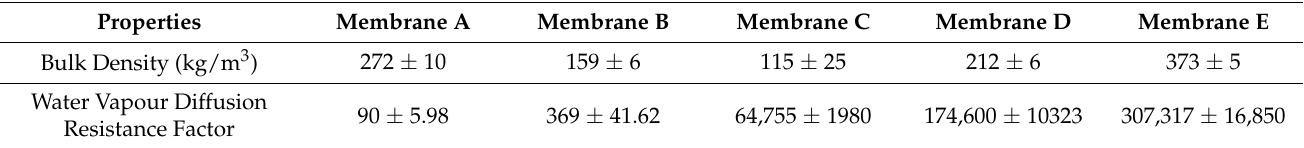
Table 2. Bulk density and single point water vapour diffusion resistance factor of the five tested pliable